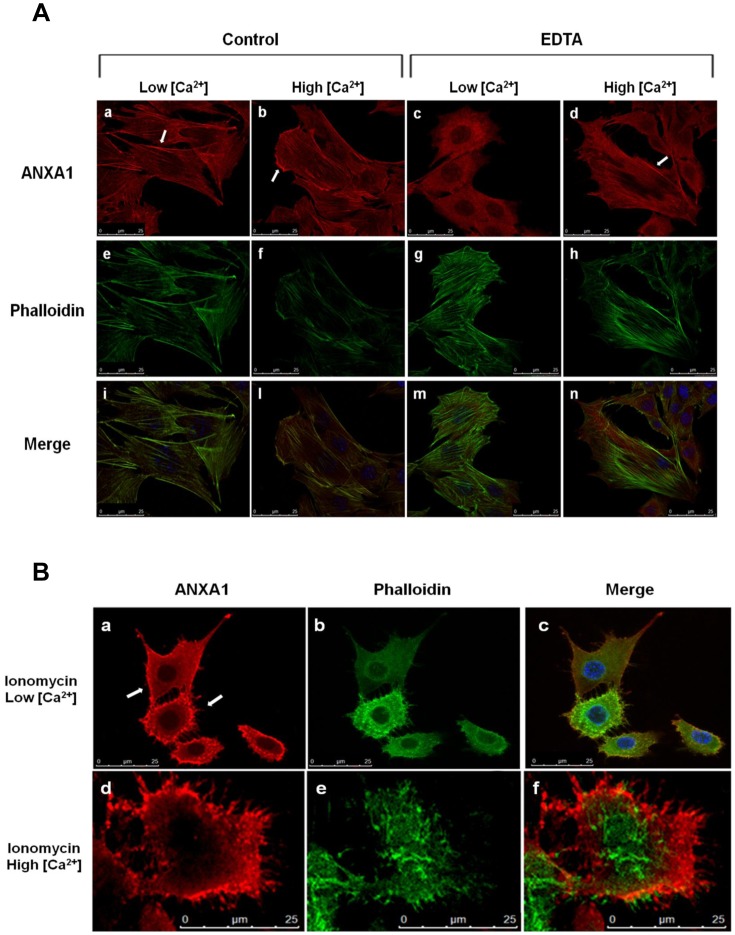
ANXA1 cellular relocation following Ca2+ challenge. (A)Cultured murine C2C12 myoblasts fixed and labeled with fluorescent antibody against ANXA1 and with FITC-conjugated Phalloidin in Ca2+-free conditions (a, c, e, g) and in a medium containing 2 mM Ca2+ (b, d, f, h). (B) An increase of intracellular Ca2+ levels leads to ANXA1 relocation to the plasma membrane (a); at high Ca2+ concentrations actin filaments (green) are significantly damaged by high intracellular increase of Ca2+ level (e): in this condition ANXA1(red) is strikingly shifted to the plasma membrane (d). Bar = 25 µm.